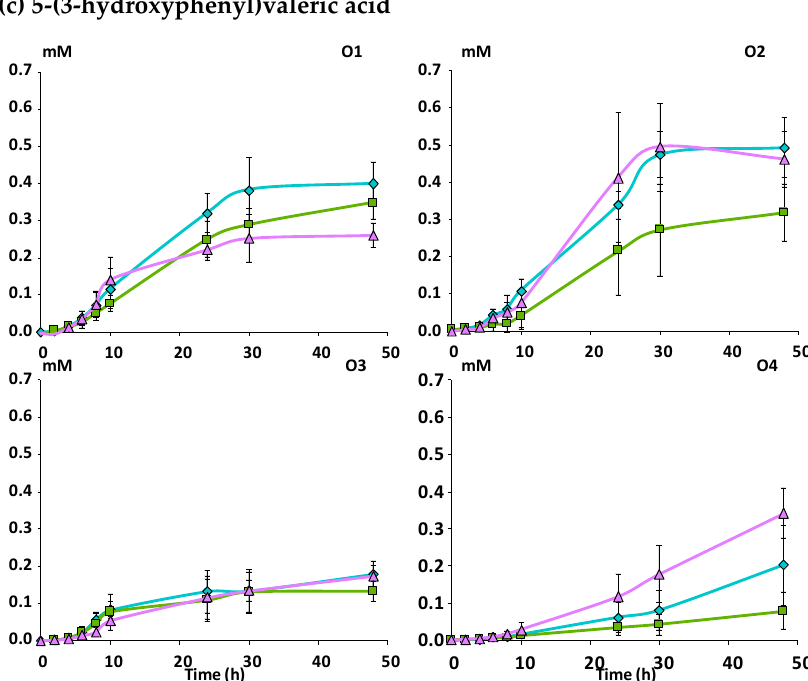
Figure 3. Kinetics of production of phenylpropionic acid derivatives during in vitro fermentation of the apple matrices with fecal microbiota ( n = 3) from four healthy subjects. Mean Figure 1. Kinetics of production of short chain fatty acids during in vitro fermentation of the Figure 5. Kinetics of production of phenylvalerolactone and phenylvaleric acid derivatives Figure 5. Kinetics of production of phenylvalerolactone and phenylvaleric acid derivatives Figure 4. Kinetics of production of phenylacetic acid derivatives during in vitro fermentation of concentrations in mM of ( a ) 3-(3,4-dihydroxyphenyl)propionic acid, ( b ) 3-(3- apple matrices with fecal microbiota ( n = 3) from four healthy subjects. Experimental and during in vitro fermentation of the apple matrices with fecal microbiota ( n = 3) from four during in vitro fermentation of the apple matrices with fecal microbiota ( n = 3) from four healthy the apple matrices with fecal microbiota ( n = 3) from four healthy subjects. Mean concentrations hydroxyphenyl)propionic acid, (c) 3-(4-hydroxyphenyl)propionic acid, (d) 3-phenylpropionic modelled data for acetate ( a ) propionate ( b ) and butyrate production ( c ). Each point represents healthy subjects. Mean concentrations in mM of ( a ) 5-(3,4-dihydroxyphenyl)- G -valerolactone, subjects. Mean concentrations in mM of ( a ) 5-(3,4-dihydroxyphenyl)- ɣ -valerolactone, ( b ) 5-(3- in mM of ( a ) 3,4-dihydroxyphenylacetic acid and ( b ) 3-hydroxyphenylacetic acid. Error bars acid. Error bars represent the standard error of the mean ( n = 3 ). O1 to O4: subject 1 to 4. Mcov the mean concentrations of SCFAs expressed in mM. Bars represent the standard error of the ( b ) 5-(3-hydroxyphenyl)- G -valerolactone, ( c ) 5-(3-hydroxyphenyl)valeric acid. Error bars represent hydroxyphenyl)- ɣ -valerolactone, ( c ) 5-(3-hydroxyphenyl)valeric acid. Error bars represent the represent the standard error of the mean ( n = 3 ). O1 to O4: subject 1 to 4. Mcov matrix, matrix, Mnc matrix, Mno matrix. the standard error of the mean ( n = 3). O1 to O4: subject 1 to 4. Mcov matrix, mean ( n= 3 ). O1 to O4: subject 1 to 4. Mcov matrix, Mnc matrix, Mno matrix standard error of the mean ( n= 3 ). O1 to O4: subject 1 to 4. Mcov matrix, Mnc matrix, Mnc matrix, Mno matrix. Mno Table 2. Rates of SCFA production and procyanidin degradation during in vitro fermentation of the apple matrices with fecal microbiota ( n = 3) from four healthy donors 1.